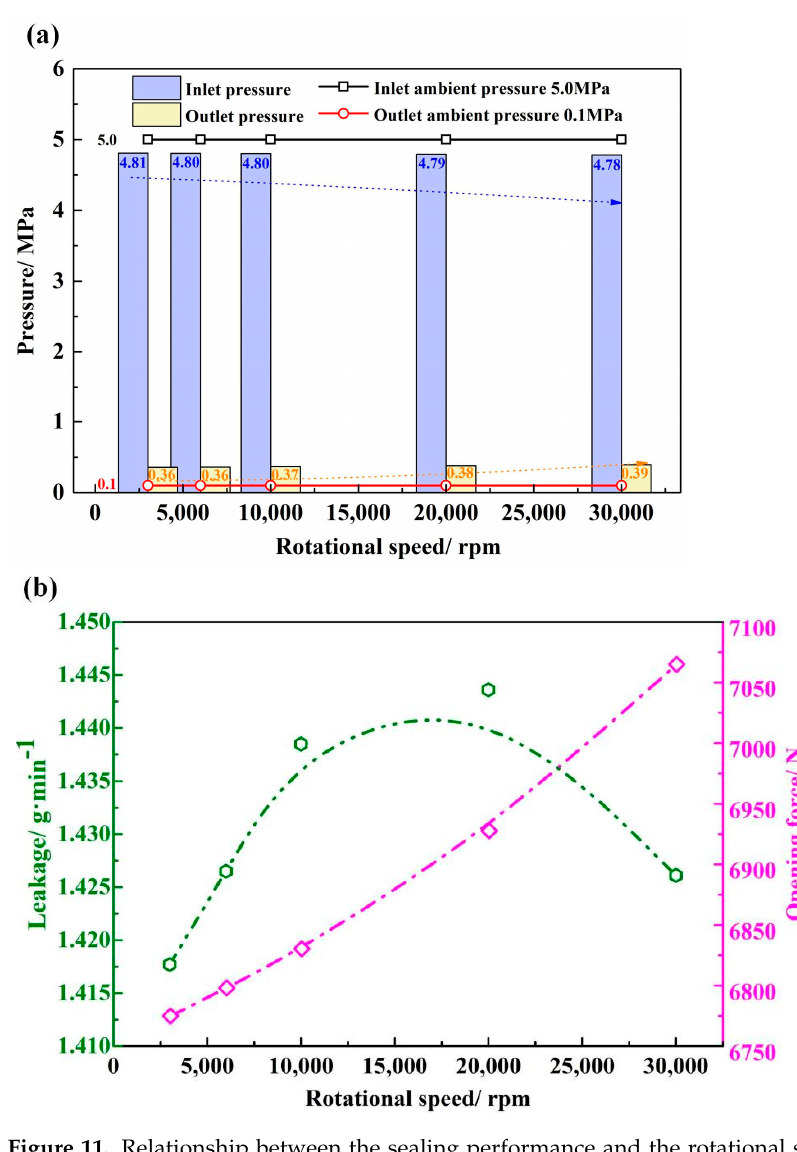
Figure 11. Relationship between the sealing performance and the rotational speed. ( a ) Pressure boundaries between the seal rings; ( b ) Opening force and leakage. ( P in = 5.0 MPa, P out = 0.1 MPa, T in = 200 K, T out = 350 K, h 0 = 3 μ m).